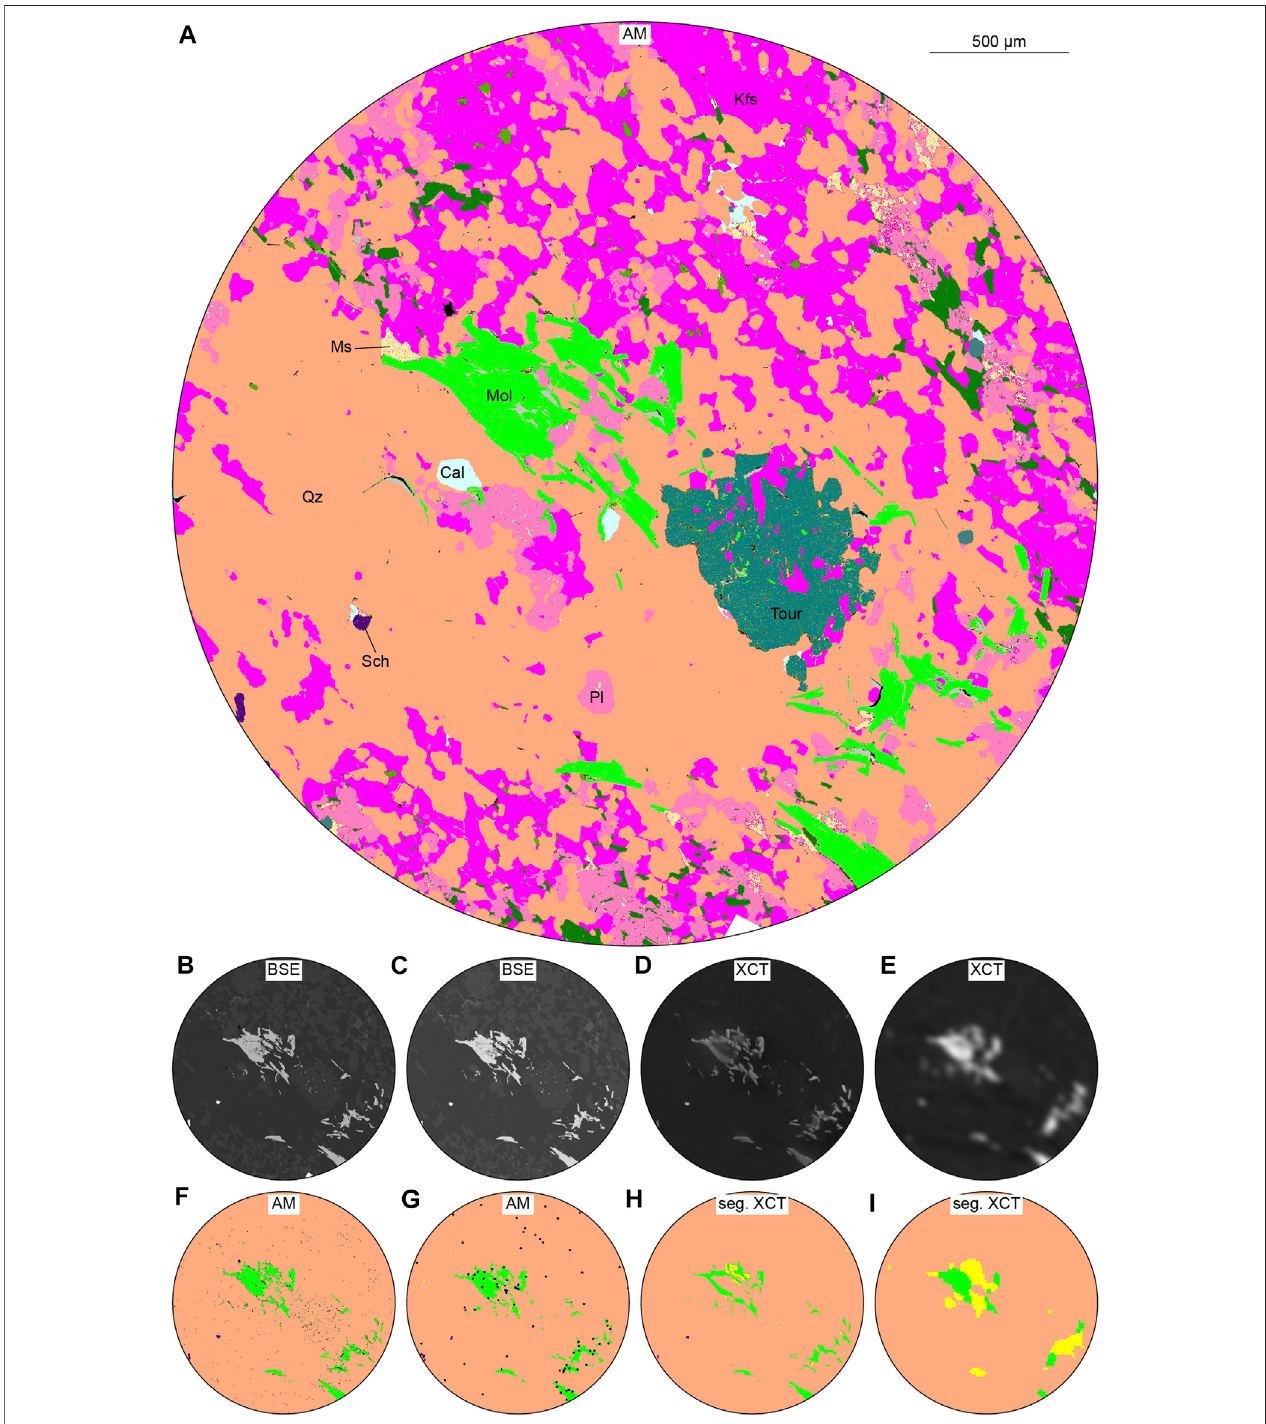
FIGURE 9 | AM and XCT images of a region of interest in the polished rock chip of sample 3. For color coding of the minerals, see Table 2 . (A) 1 μ m pixel size AM mineralmap.UneventopographyinsomemolybdenitegrainscausedissueswithEDSanalysis,renderingsomeareasinthemolybdenitegrainsunclassi fi ed. (B) 250 nm pixel size AM BSE image. (C) 1.87 μ m pixel size AM BSE image. (D) 4 μ m voxel size XCT scan. (E) 30 μ m voxel size XCT scan. (F) 1 μ m pixel size simpli fi ed AM mineral map. (G) 30 μ m pixel size simpli fi ed AM mineral map. (H) 4 μ m voxel size segmented XCT scan. (I) 30 μ m voxel size segmented XCT scan. Abbreviations: Cal – calcite, Kfs – k-feldspar, Mol – molybdenite, Ms – muscovite, Pl – plagioclase, Sch – scheelite, Tour – tourmaline, Qz – quartz.